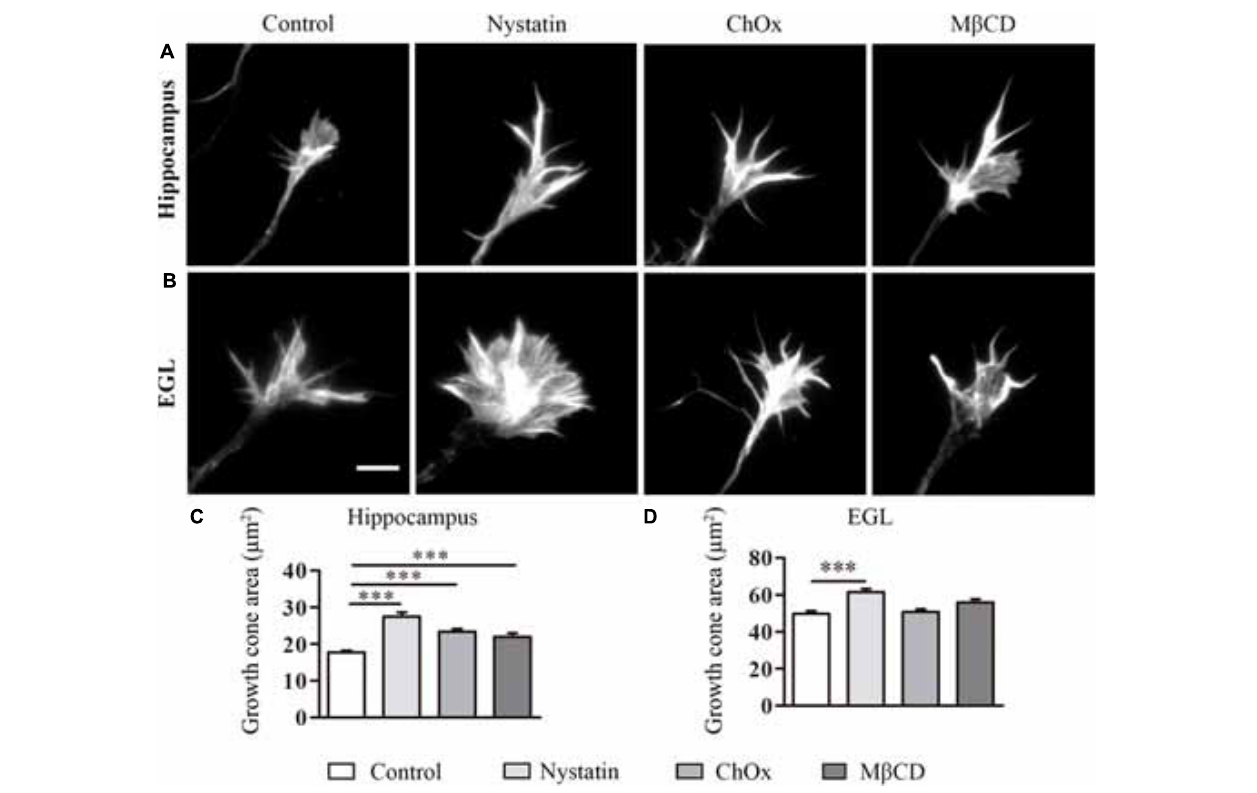
FIGURE 1 | Cholesterol depletion increases growth cone area in hippocampal neurons and EGL neurons. Examples of hippocampal (A) and EGL (B) growth cones treated with control culture media, 2.5 µ g/ml Nystatin, 2U ChOx, and 0.5 mM M β CD and stained with phalloidin. Growth cones areas from three independent experiments were measured. Data represent means ± SEM (C,D) . N = 150–250 growth cones in each condition (One-way ANOVA, Dunnett’s Multiple comparison test ∗∗∗ p < 0.0001). Scale bar 5 µ m.